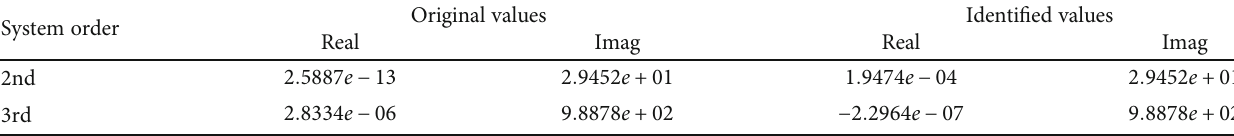
between the original and identi fi ed system. c